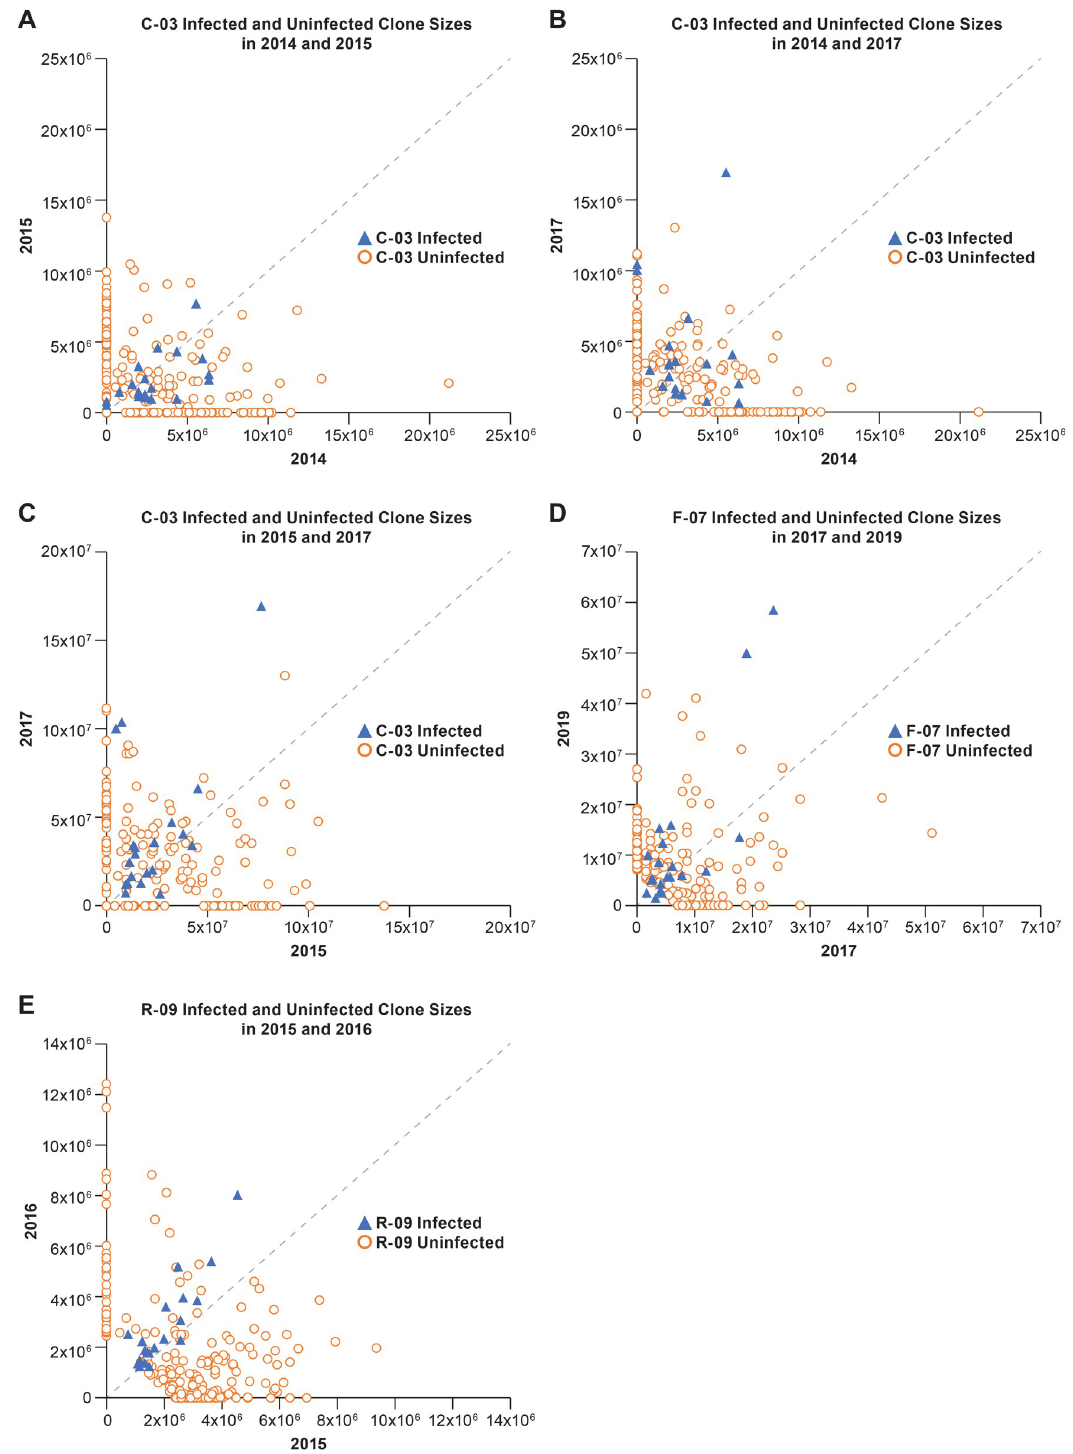
Fig 2. Scatter plots showing the stabilities of clones of infected and uninfected CD4+ T cells. Each panel shows the sizes of the 20 largest clones of infected T cells (blue triangles) and the sizes of 200 clones of uninfected T cells of a similar size at two different times. The dotted line is the diagonal. Any clone whose size does not change between the time points shown on the axes would fall on this diagonal. Similarly, the change in the sizes of each of the clones can be measured by the distance from the diagonal. Each panel (A-E) shows a comparison for two time points; the donors and the times are noted in each of the panels.